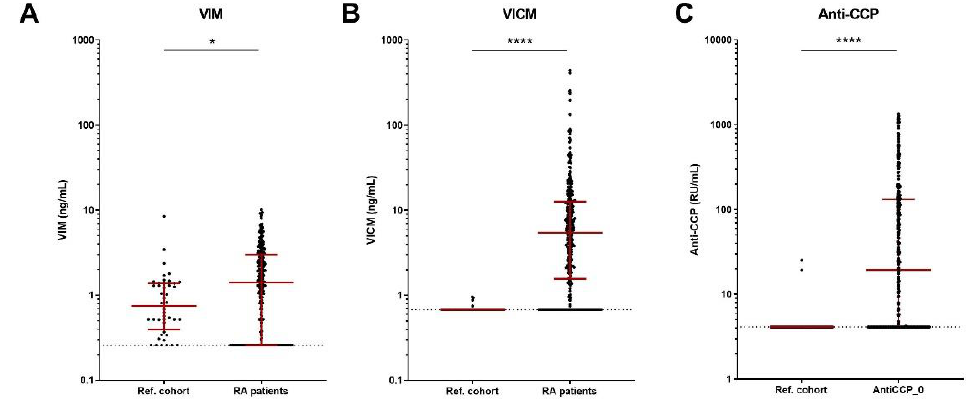
Figure 1. Comparing the level of markers between the reference cohort (n = 64) with the AMBITION patients (n = 257): ( A ) VIM (n vim = 44 subjects (see Methods section)).; ( B ) VICM; ( C ) anti-CCP. Comparisons between groups were conducted on ln-transformed biomarker data by ANCOVA adjusting for age, sex and race. Data are depicted as scattergrams with median and IQR in red. The dotted line indicates the lower detection limit of the assay. *, p < 0.05 and ****, p <